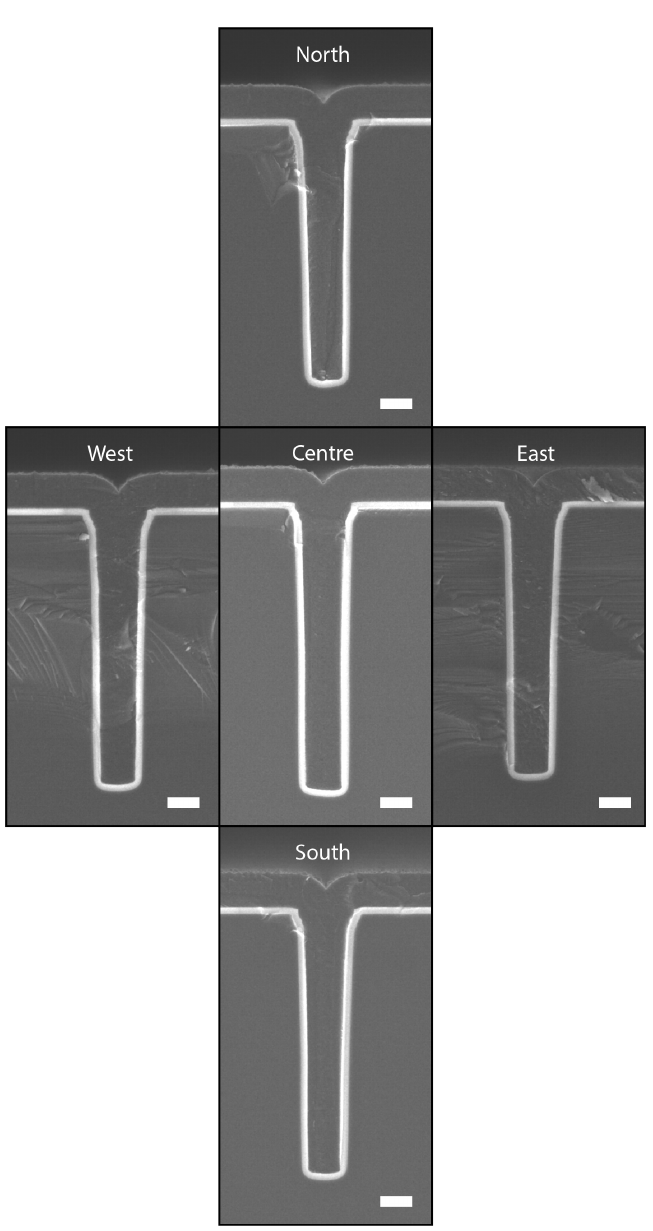
Figure 17. Cross-sectional SEM inspection of the wafer-scale uniformity in refilled trenches. Etch settings used during the trench etch were 1.5s etch time at 40mTorr process pressure and using 40W CCP LF power. An aspect ratio of 6 was reached. The north, east, south, and west position were imaged at locations next to the 1cm edge exclusion. All scale bars are